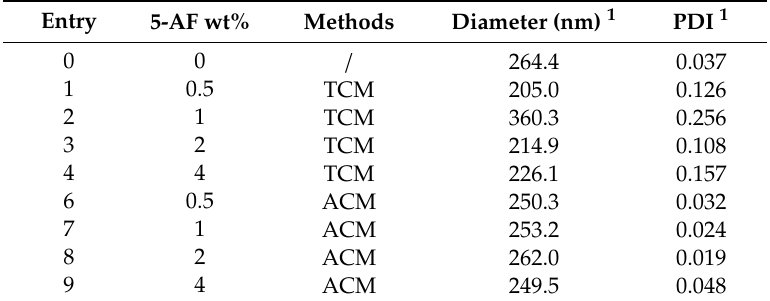
Table 2. Diameter of hairy nanospheres (HNs) synthesized by di ff erent methods.